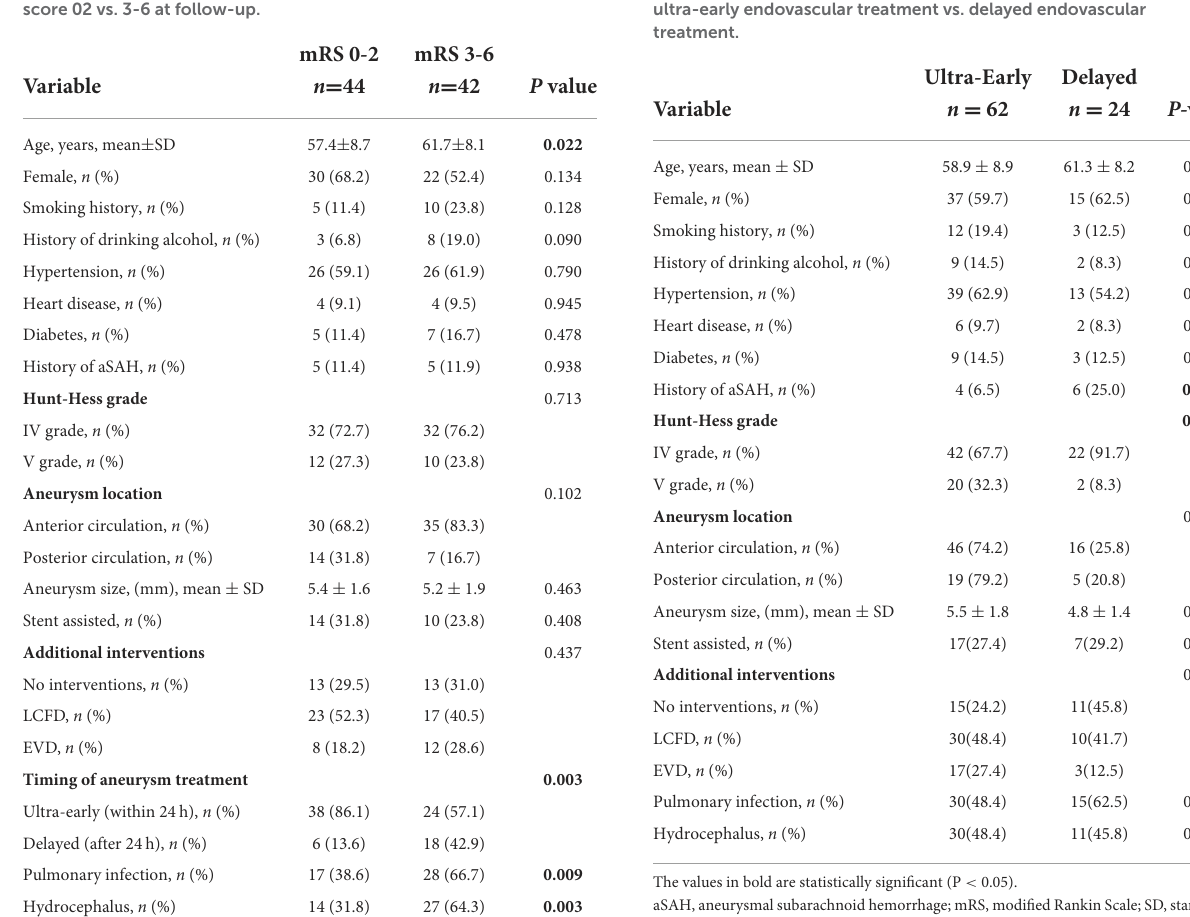
TABLE 2 Comparison of demographic, clinical, aneurysm, and treatment characteristics of patients with high-grade aSAH with mRS score 02 vs. 3-6 at follow-up.